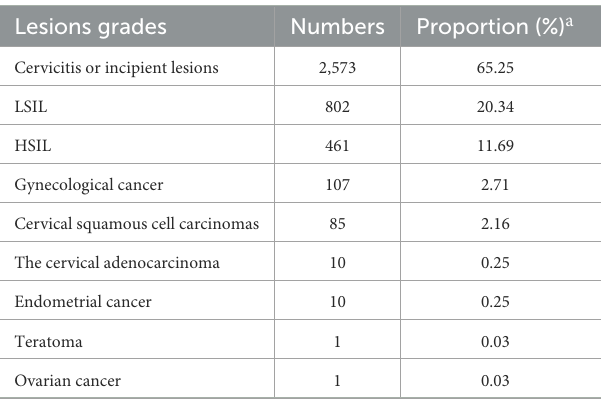
TABLE 3 Proportion of different lesion grades in 3,943 HR-HPV positive women with cervical cytology. Lesions grades